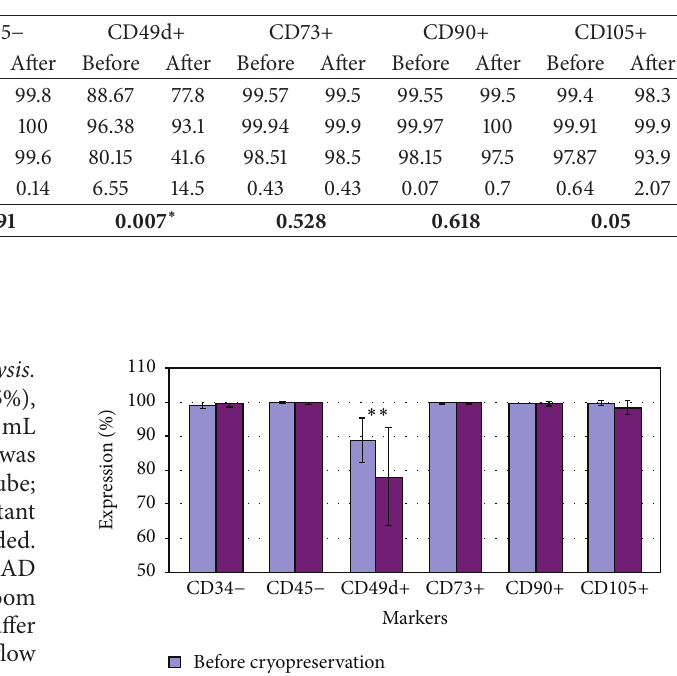
Table 2: Surface markers expressions before cryopreservation and after thawing.